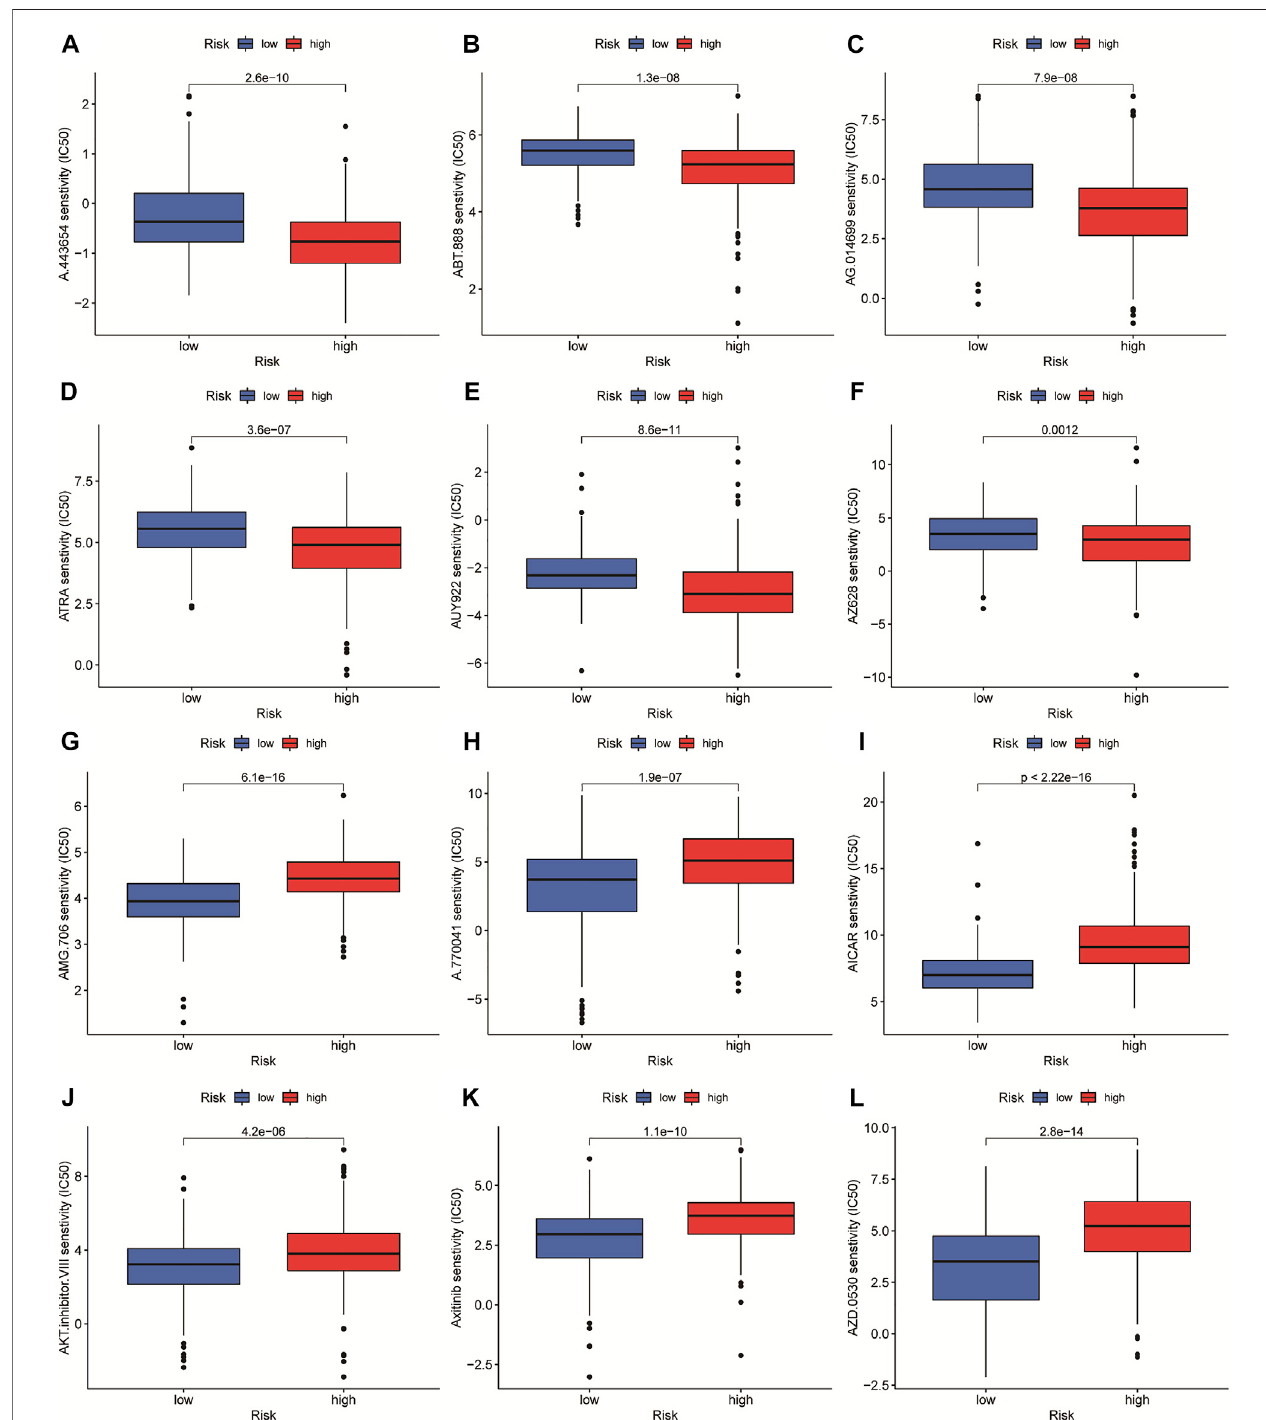
FIGURE 10 | The investigation of tumor immunotherapy. The drugs prediction of risk